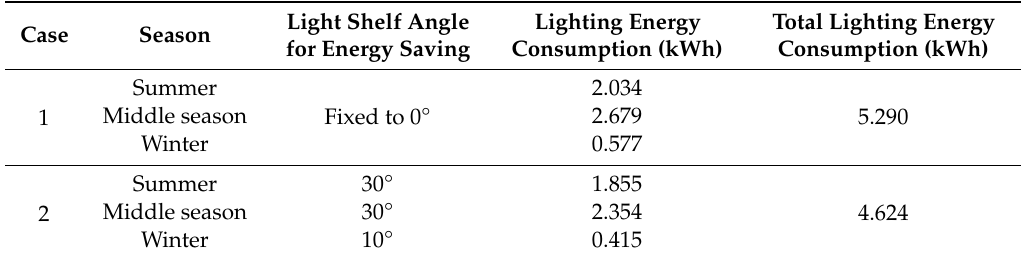
Table 8. Light shelf angle for lighting energy saving and total lighting energy consumption for Case 1 and Case